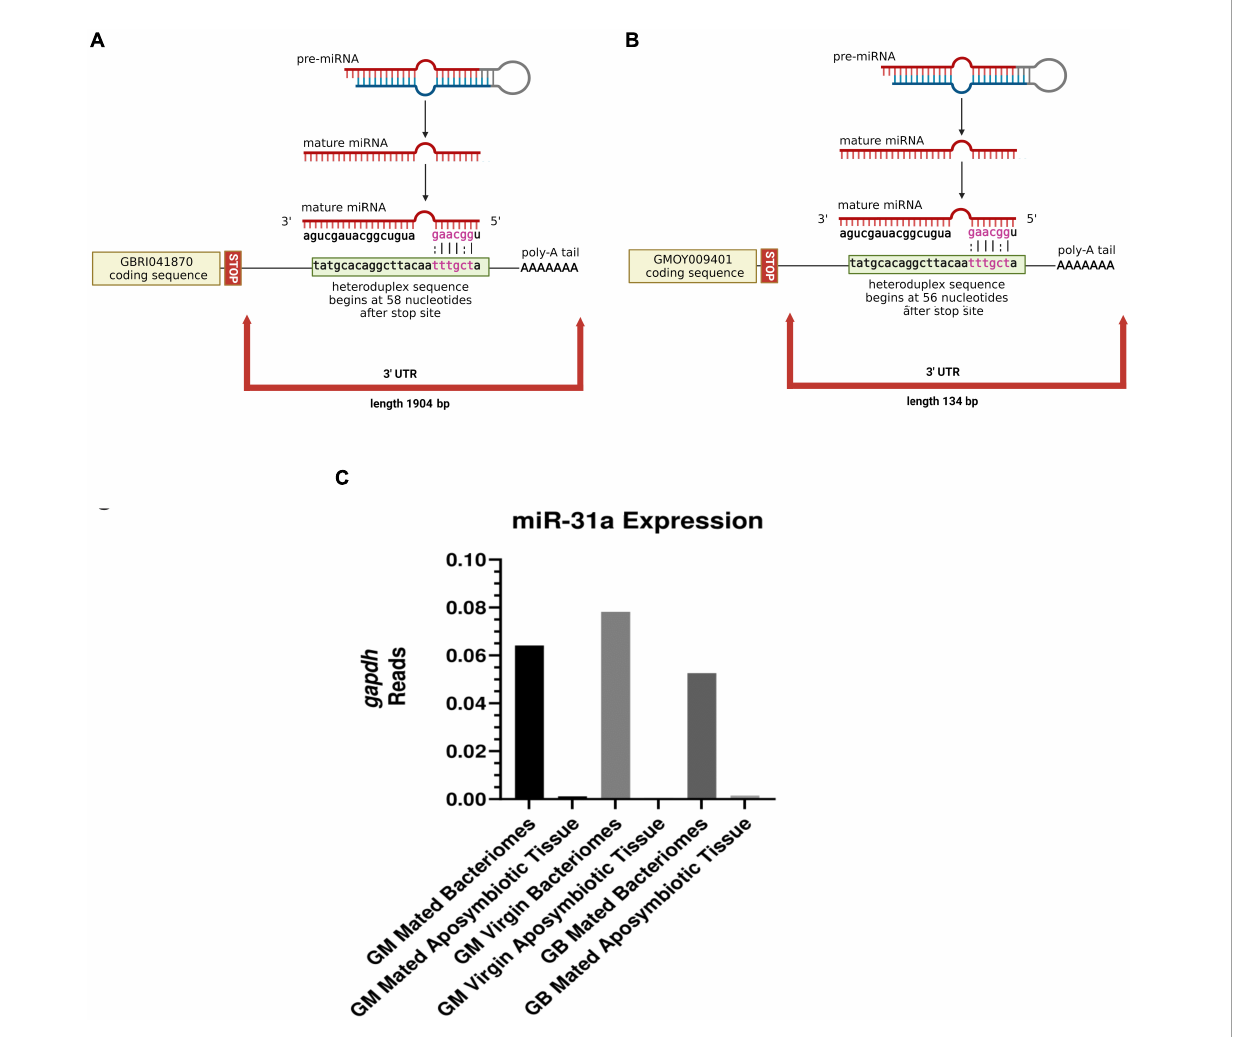
FIGURE5 The predicted heteroduplex formations of fatty acyl-coA reductase in (A) G. brevipalpis (GBRI041870) and (B) G. morsitans (GMOY009401) and (C) the relative expression patterns of miR-31a to gapDH in the libraries examined. Nucleotides in pink represent the seed region and heteroduplex formation, | represents binding, and : represents a